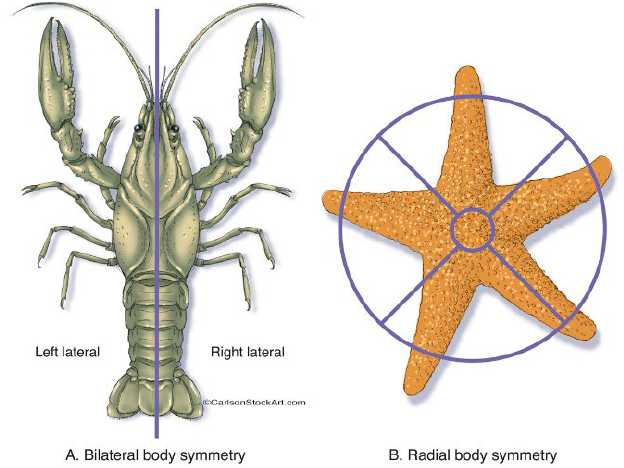
Figure 3. Bilateral ( A ) and radial symmetry ( B ) in biological